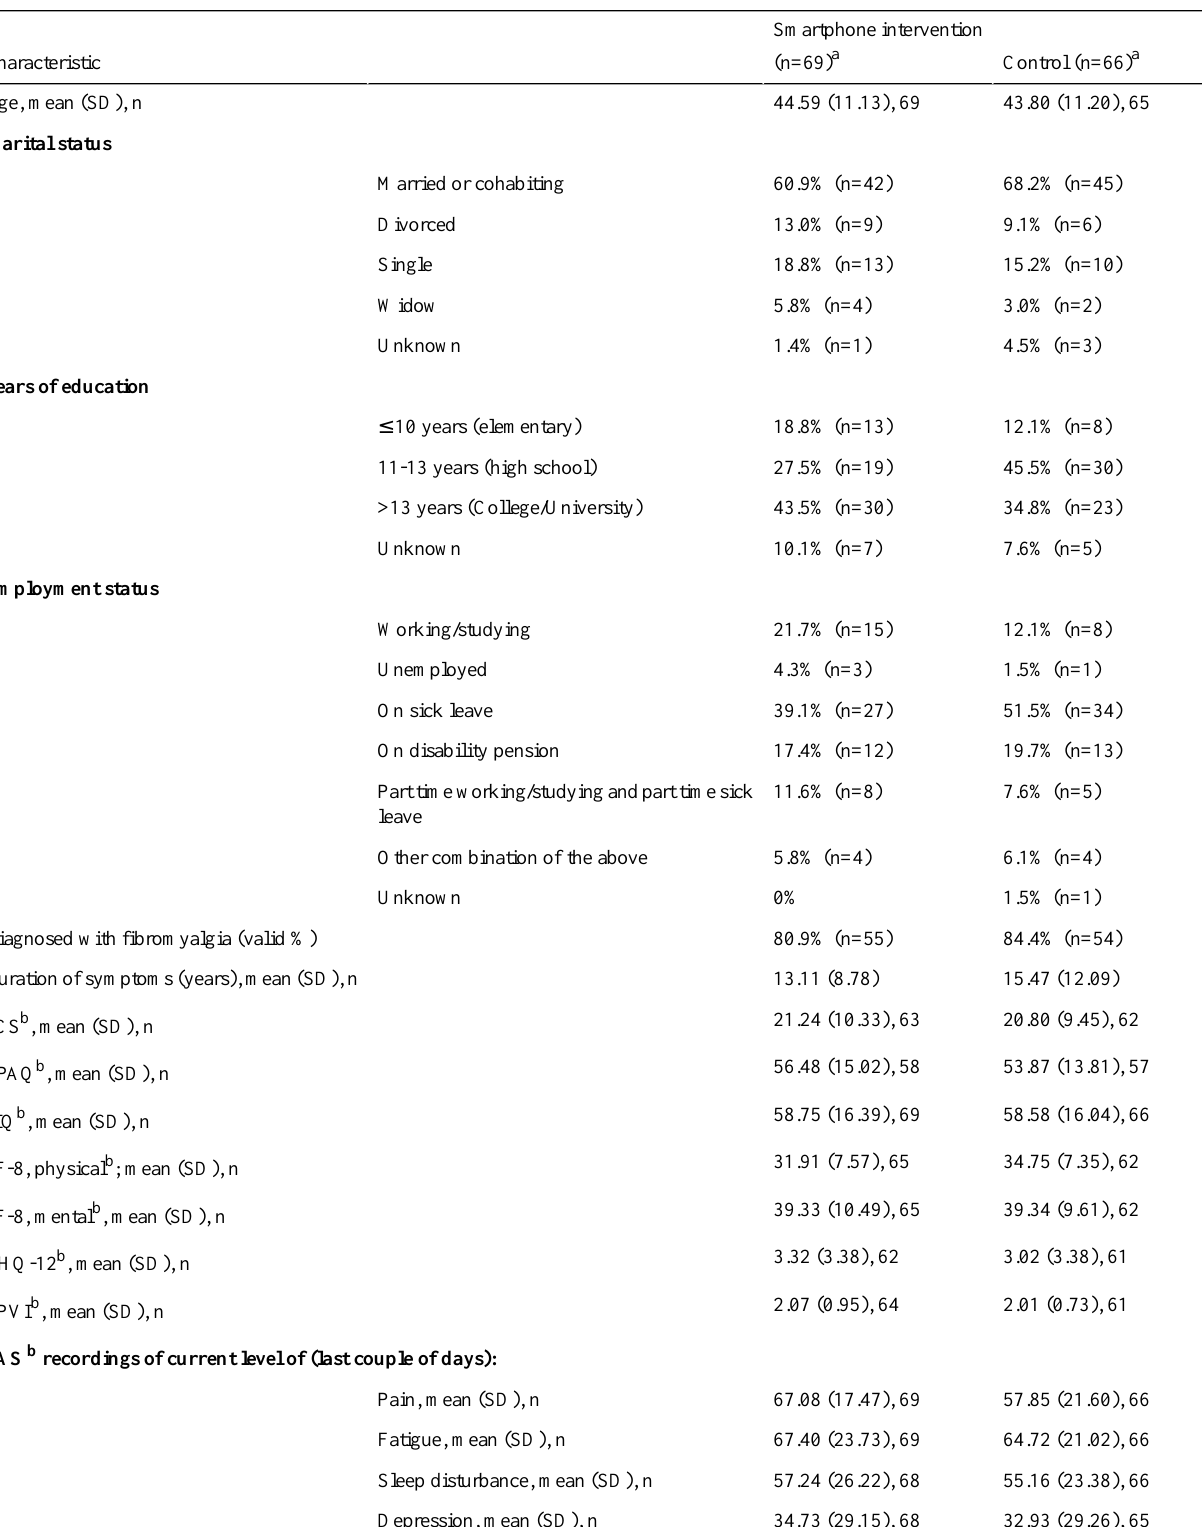
Table 1. Characteristics at admission to the inpatient rehabilitation